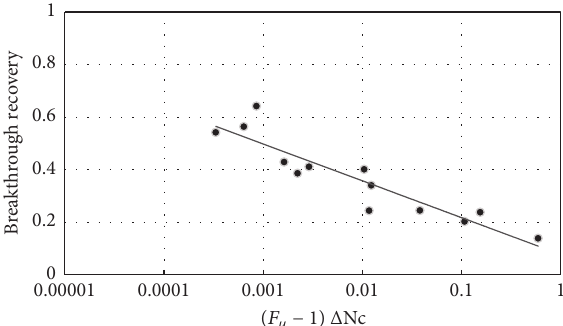
Figure 7: Decrease of breakthrough recovery versus (𝐹𝜇 − 1) ∇ Nc